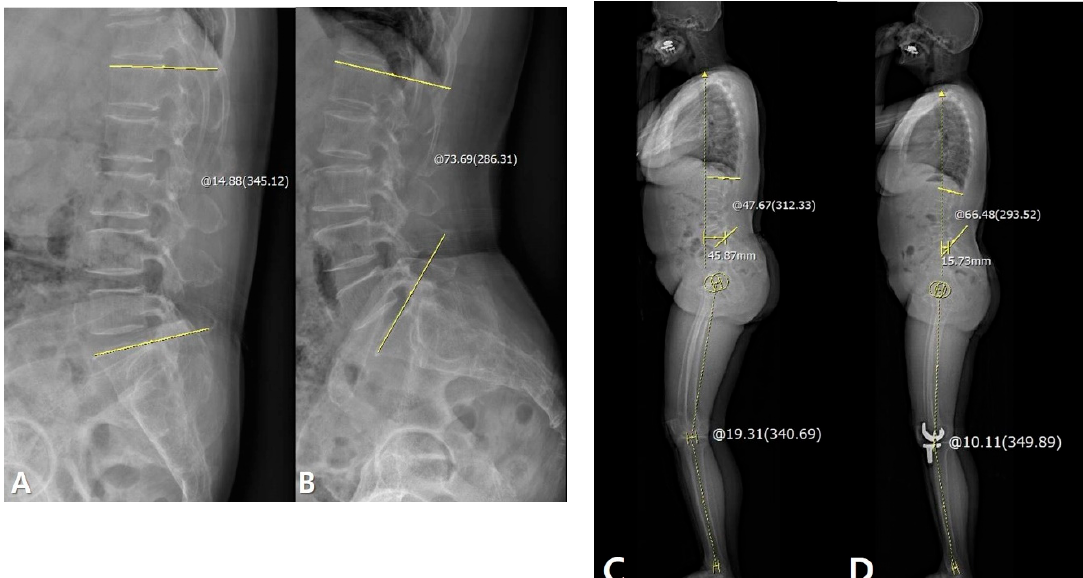
Figure 3. Patient with larger lumbar flexibility (LF) improved sagittal spinal alignment after TKA: Measurement of LF on flexion-extension view: 58.81 ◦ . ( A ) Measurement of LL on flexion view: 14.88 ◦ . ( B ) Measurement of LL on extension view: 73.69 ◦ , improved spinal alignment increased LL and decreased line-sacrum distance (SVA). ( C ) Measurement of the preoperative LL: 47.67 ◦ and SVA: 45.87 mm. ( D ) Measurement of postoperative LL: 66.48 ◦ and SVA: 15.73 mm. The yellow line and circle are the measurement about lumbar lordosis, SVA and sagittal HKA.